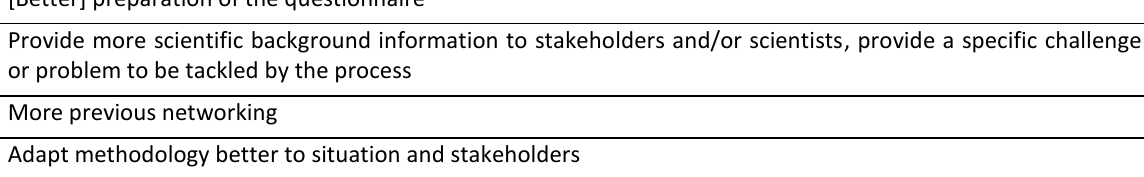
Table A3 : Selected statements on things that can be improved in stakeholder processes based on experiences of survey respondents (question